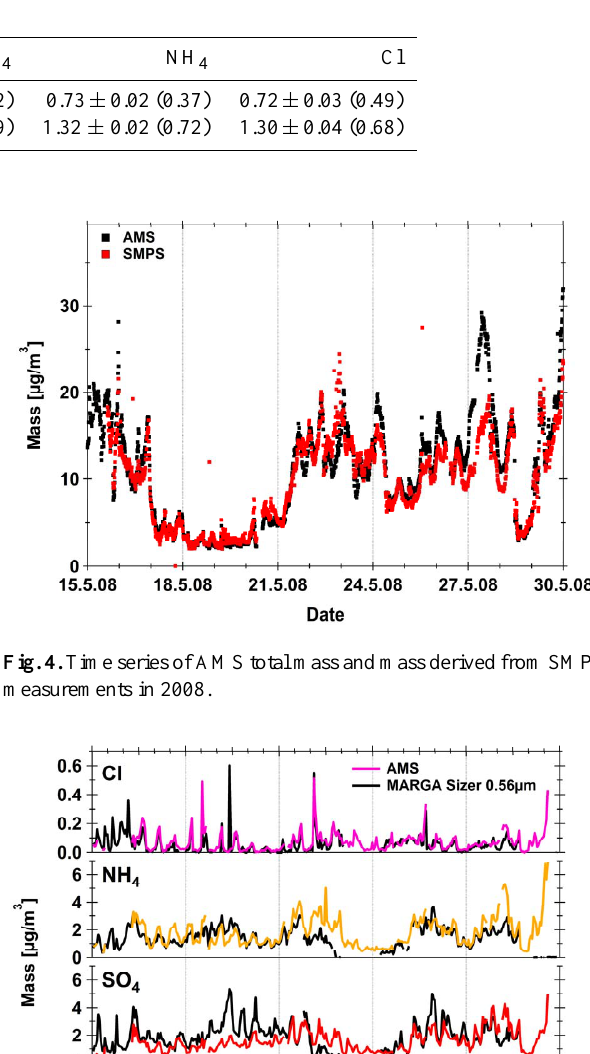
Table 1. Correlation of the 0.56µm and the 1.00µm channel of the MARGA-Sizer to AMS loadings of NO 3 , SO 4 , NH 4 and Cl. Presented are the slopes and one standard deviation of a linear regression over the entire measurement period in May 2008. The coefficient of determination ( R 2 ) is given in parenthesis.